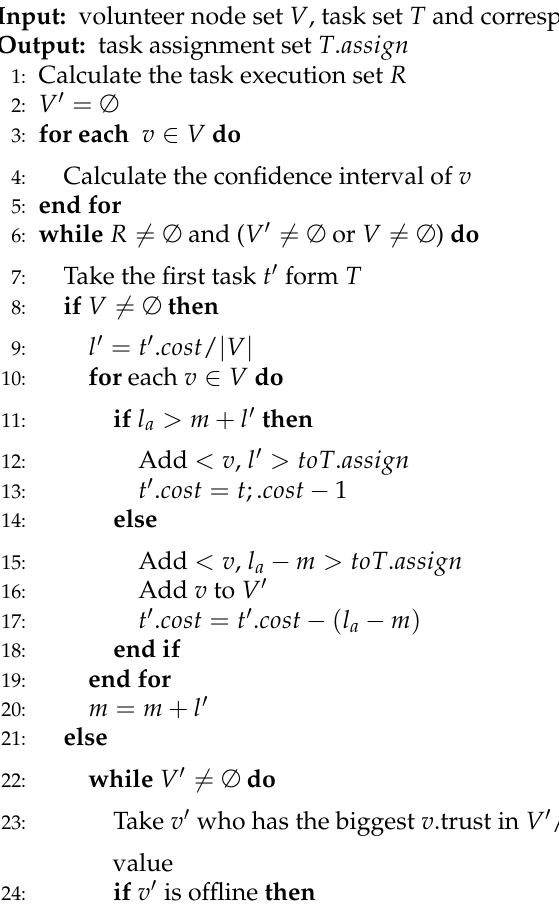
Algorithm 1 The EFTT